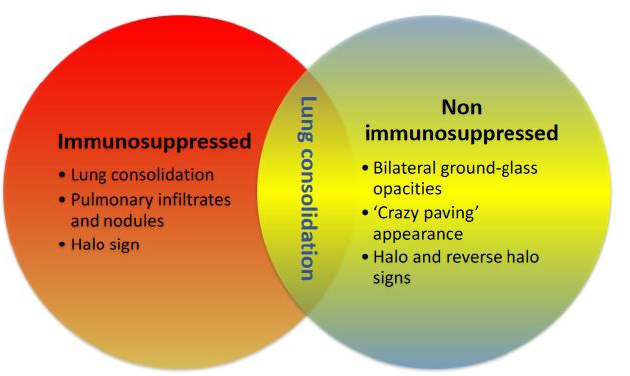
Figure 2. Radiological features of invasive pulmonary Aspergillosis if patients are or are not immu- nosuppressed.